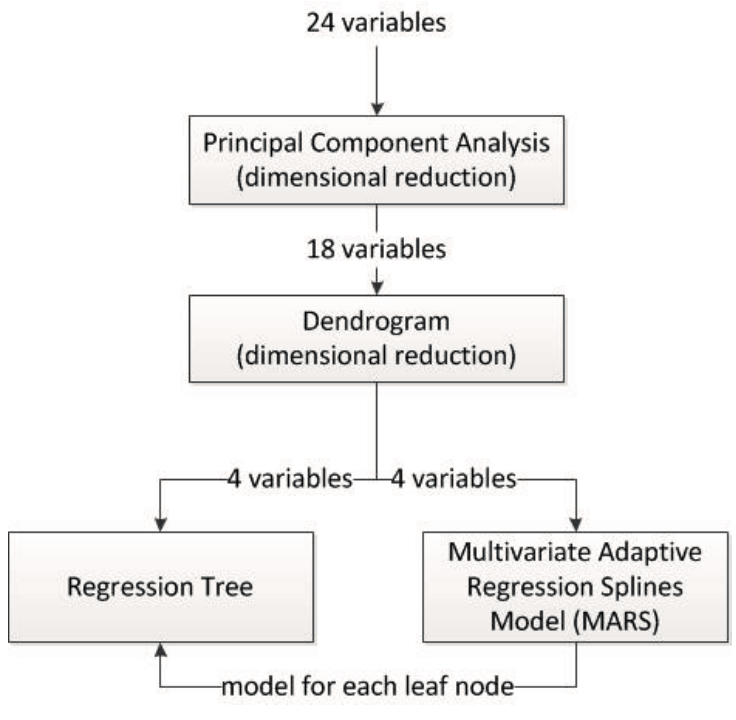
Figure 2. Flowchart of the proposed